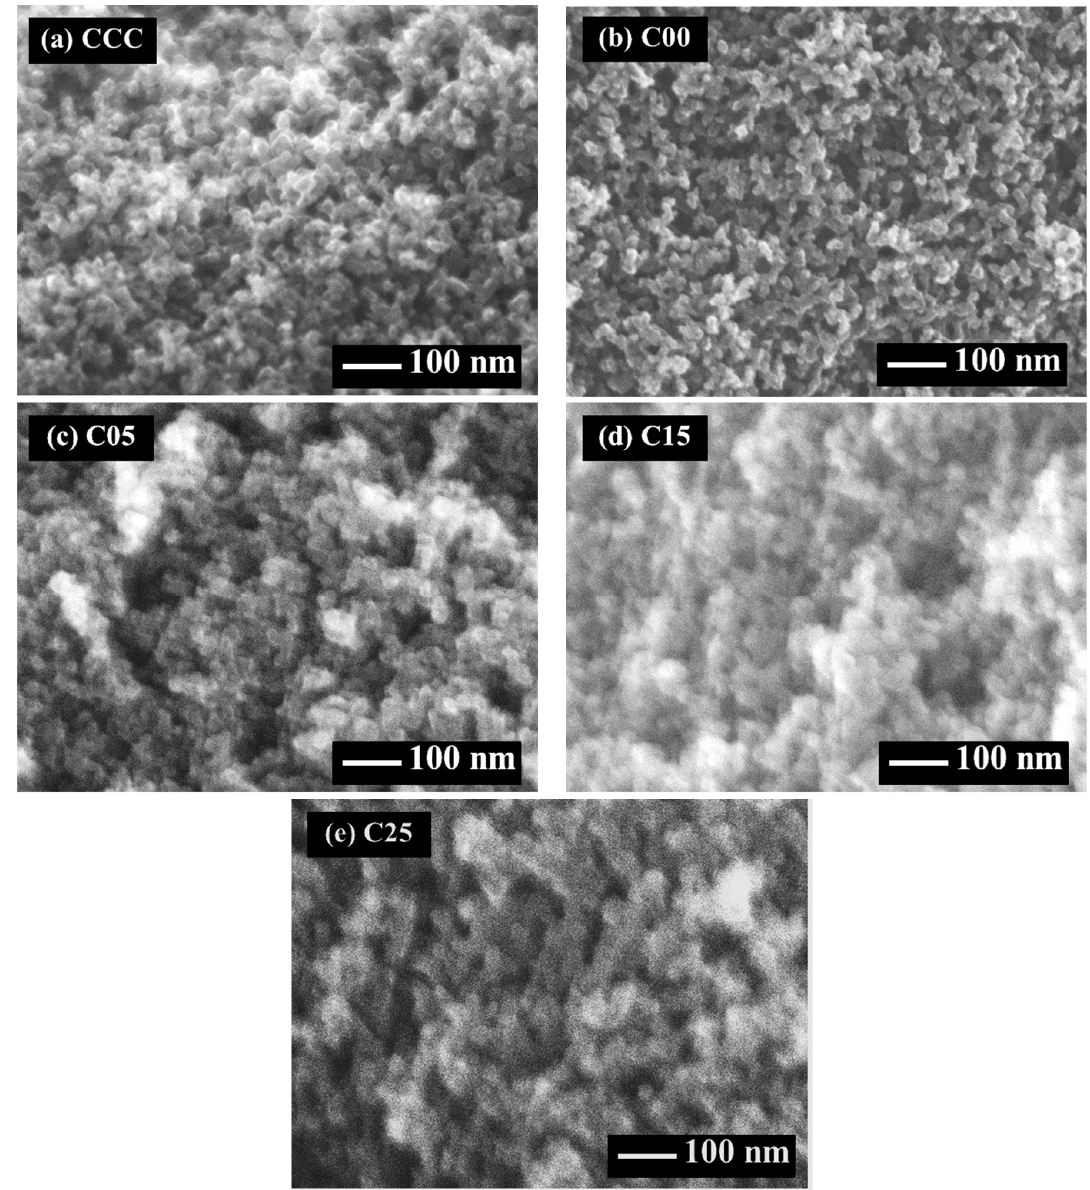
Figure 2. SEM images at 100,000× magnification of mesoporous carbon prepared at R/C = 500 mol/mol and R/W = 0.25 g/cm 3 : ( a ) carbon cryogel, ( b ) carbon xerogel, ( c ) C/C composite xerogel at CF/RF = 0.05 g/g, ( d ) C/C composite xerogel at CF/RF = 0.15 g/g, and ( e ) C/C composite xerogel at CF/RF = 0.25 g/g.